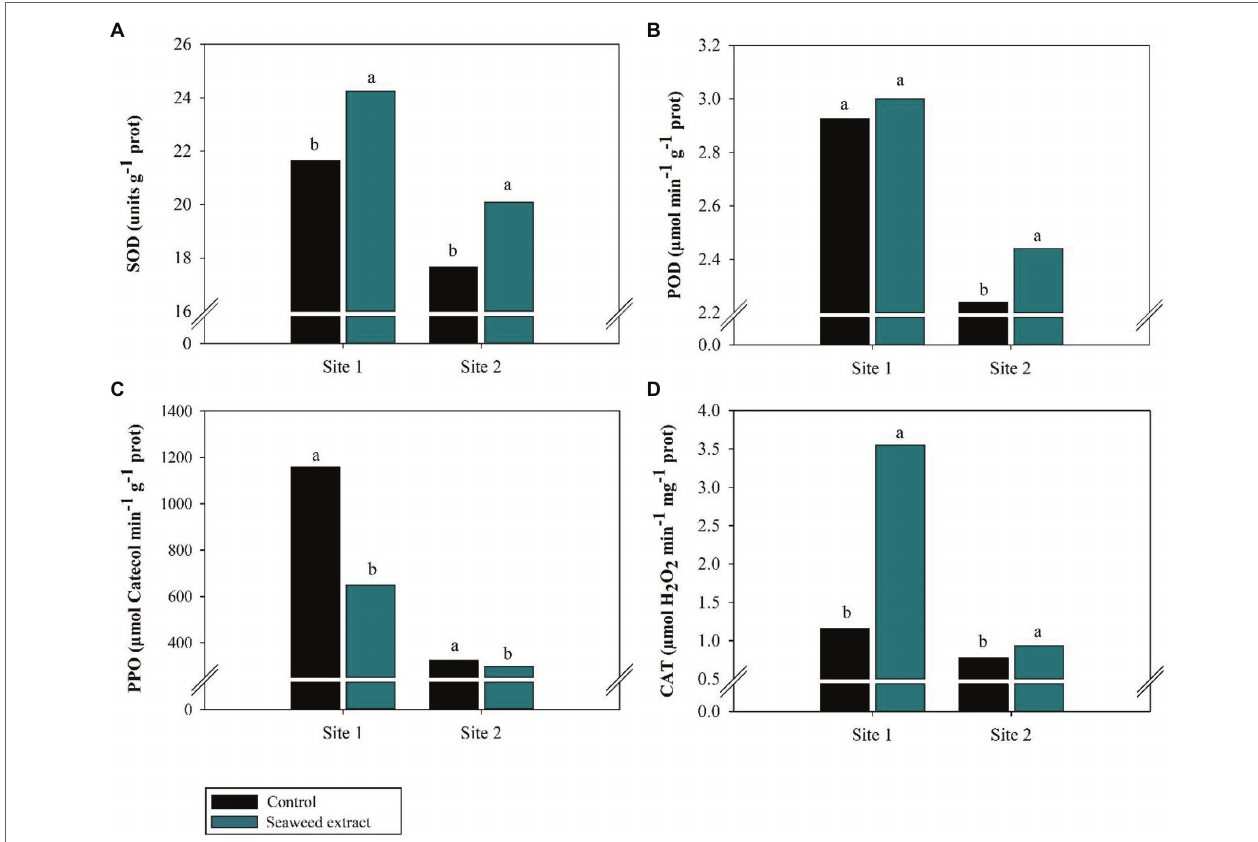
FIGURE 5 | Effects of seaweed extract (SWE) application on sugarcane antioxidant enzymatic parameters at harvest: (A) SOD (units g − 1 prot), (B) POD ( μ mol min − 1 g − 1 prot), (C) PPO ( μ mol Catechol min − 1 g − 1 prot), (D) CAT ( μ mol H 2 O 2 min − 1 mg − 1 prot). The treatments were as follows: Control, no SWE application; Seaweed extract: application of SWE biostimulant based on Ascophyllum nodosum in the beginning of the drought season (July at site 1 and June at sites 2 and 3). Averages followed by the same letters do not differ by the LSD test ( p <